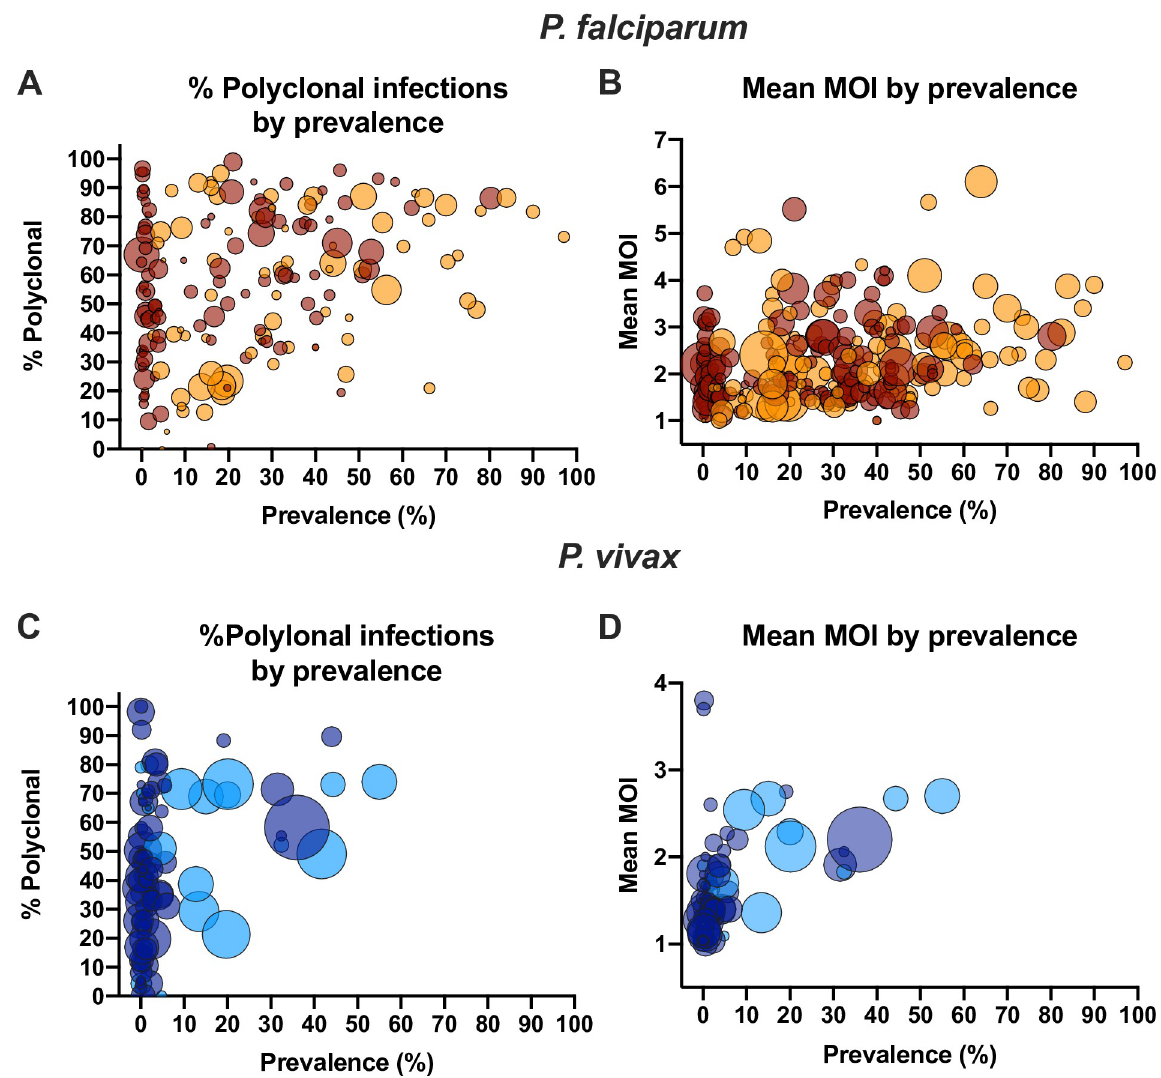
Fig 1. Relationship between prevalence and the proportion P. falciparum and P . vivax polyclonal infections (A, C) or mean multiplicity (B, D). Dot sizes represent the number of individuals genotyped. Dark red/dark blue = samples collected form clinical patients. Orange/light blue = samples collected form asymptomatic individuals. Overlapping data points result in darker